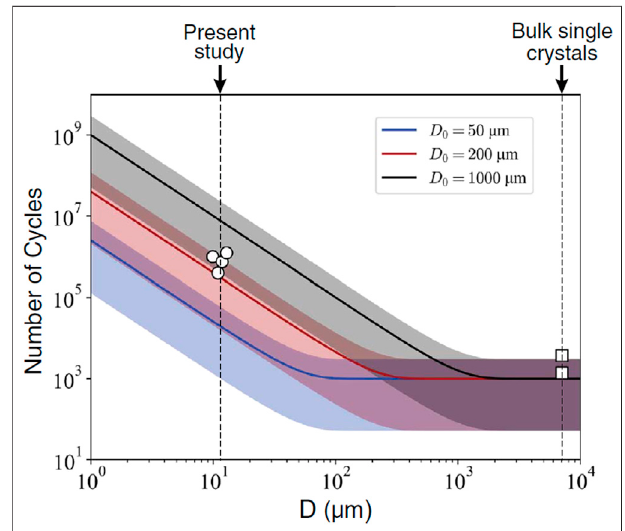
FIGURE 10 | Probabilistic model for PSB nucleation ( λ 0 = 10 − 3 ) (Reprinted with permission from Lavenstein et al. (2020) Copyright 2020 by American Association for the Advancement of